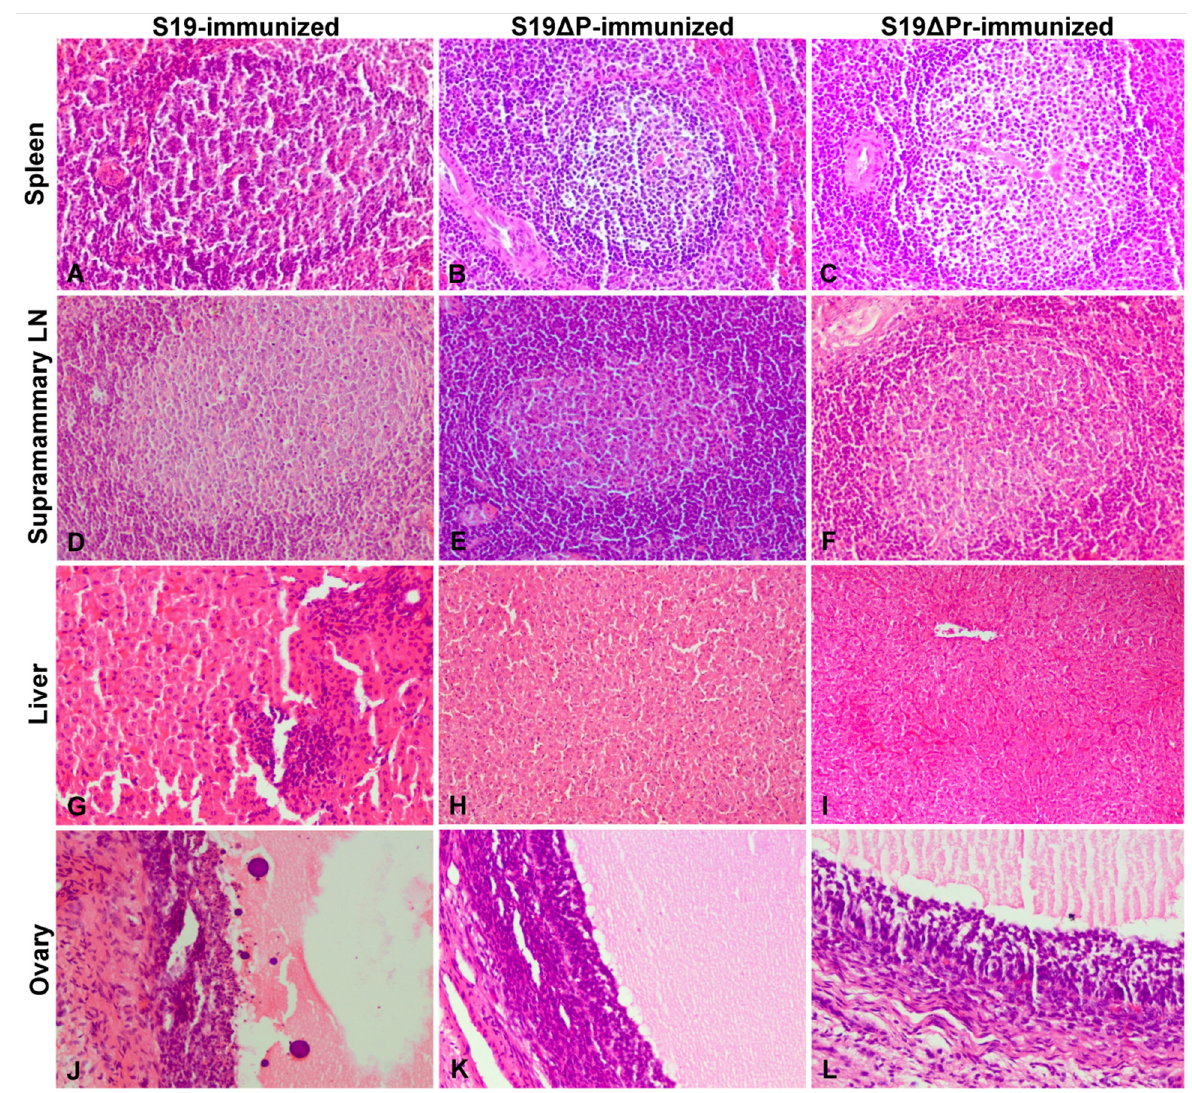
Figure 6. The histopathological lesions in various organs of immunized buffaloes are shown. ( A – C ) Spleen showed lymphoid hyperplasia with germinal center formation in white pulp. ( D – F ) Supramammary LN showed marked hyperplasia of lymphoid follicles with germinal center formation in cortex. ( G ) Liver showed multi-focal inflammatory cell infiltration. ( H , I ) Liver showed normal central vein with hepatic cords and normal sinusoidal space. ( J ) Ovary showed necrosis and apoptosis (chromatin condensation and apoptotic bodies) of granulosa cells, and reduced amount of follicular antral fluid in an early tertiary follicle. ( K , L ) Portion of the wall of tertiary or Graafian follicle showed normal theca externa, interna and granulosa cells of ovary. Tissue sections were stained with H&E staining and images were acquired at 200× magnification using light microscope.